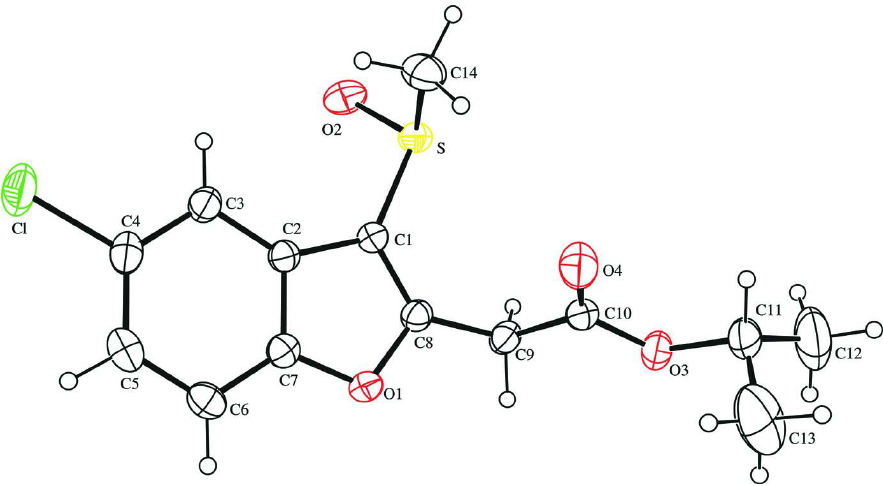
Figure 1 The molecular structure of the title compound, showing displacement ellipsoids drawn at the 30% probability level.